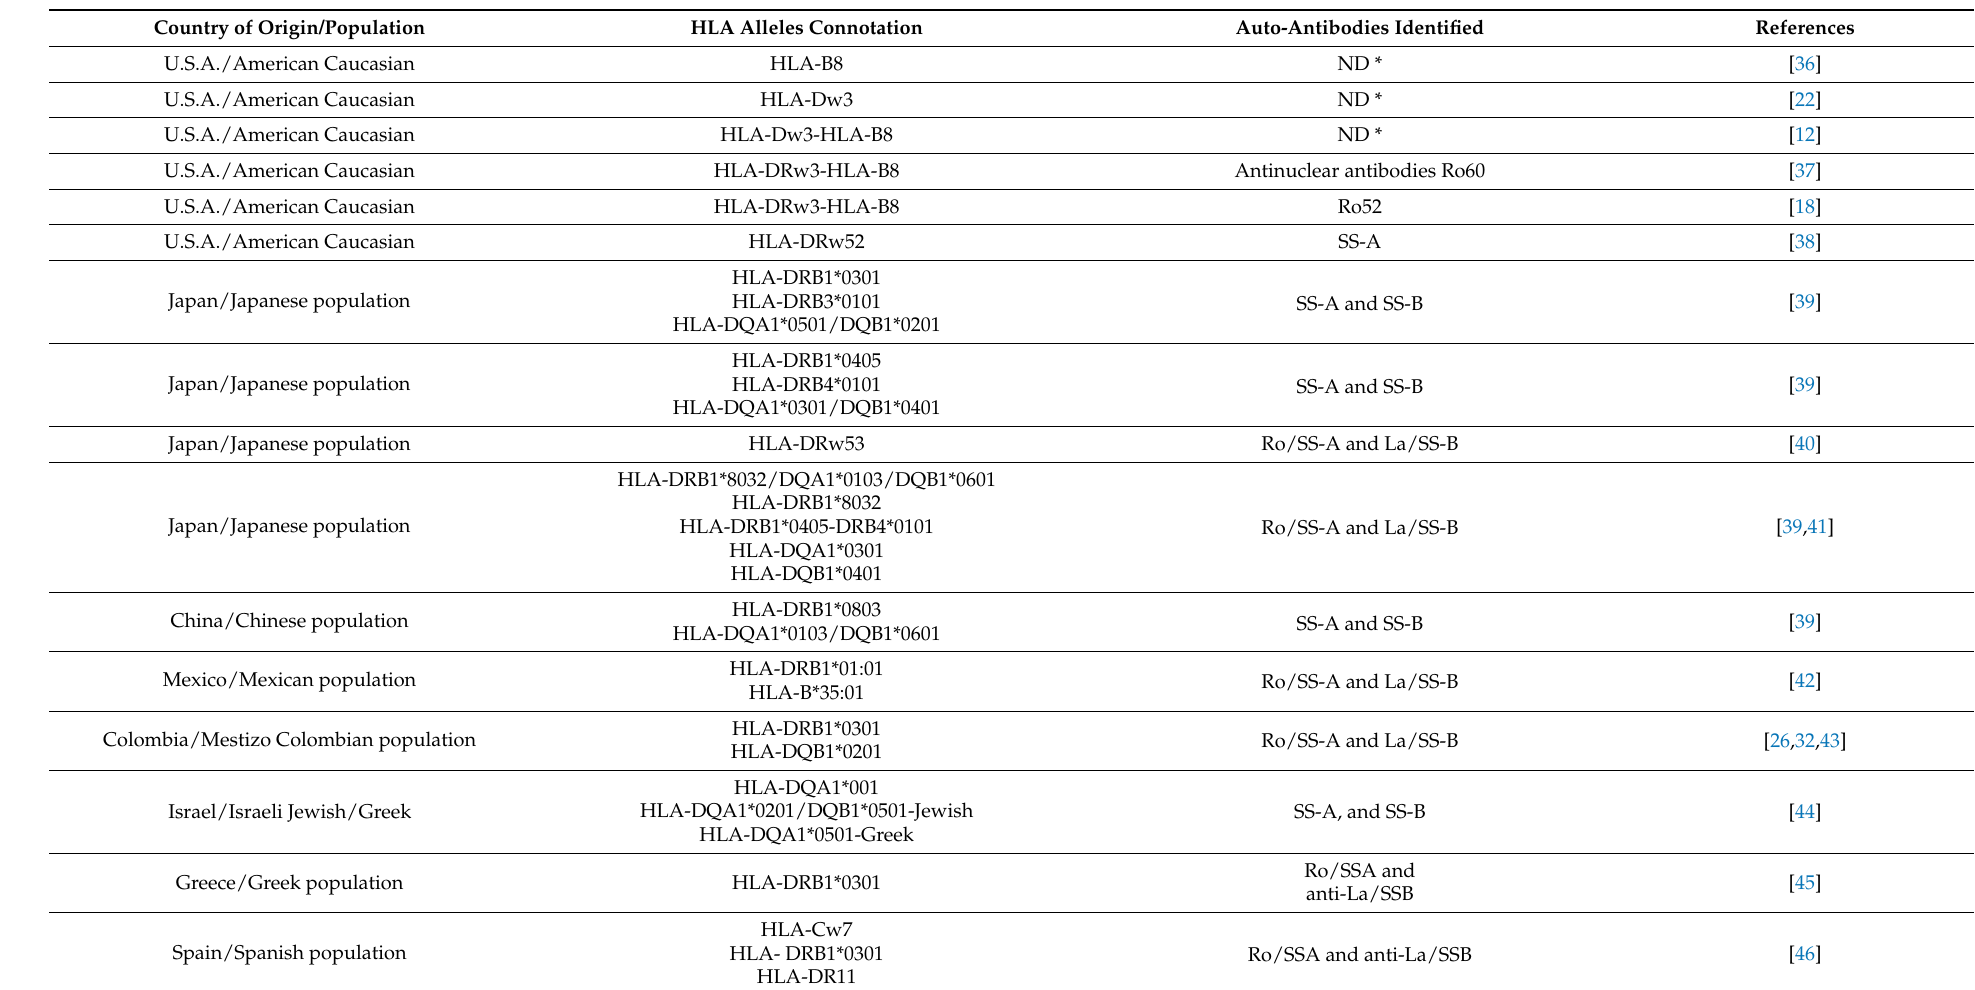
Table 1. Identifying high-risk human leukocyte antigen (HLA) alleles in Sjögren’s syndrome